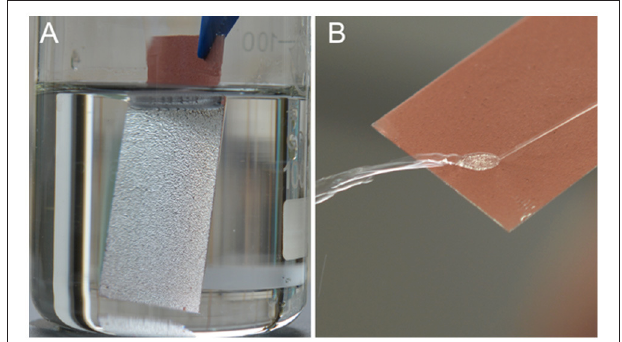
FIGURE 6 | (A) A PAL/IOR@fluoroPOS coating immersed in n -hexadecane and (B) a jetting of n -hexadecane bouncing off the coating. C PAL / IOR = 14g L − 1 , t grinding = 20min, C PFDTES = 27.2mM, C TEOS =